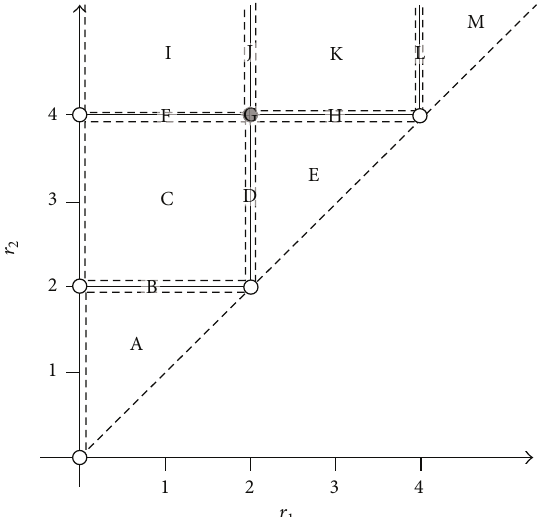
Figure 1: The 13 cases depicted in the 𝑟 1 𝑟 2 plane in the order of